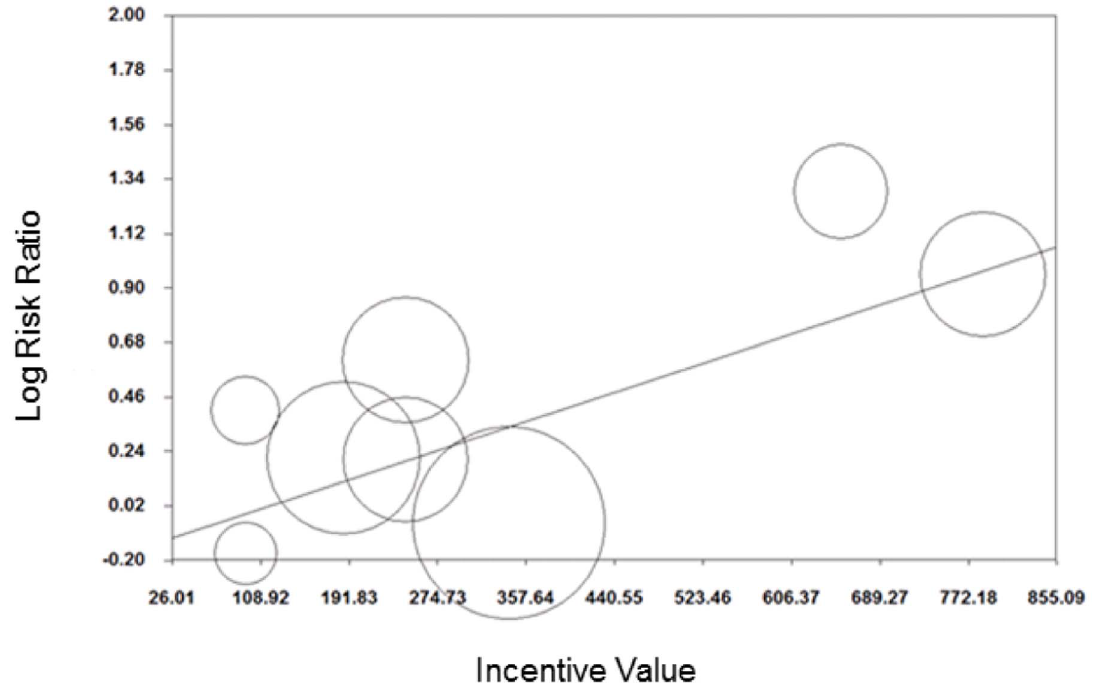
Figure 8. Meta-regression of incentive value on relative risk, smoking cessation (follow-up of . six months).